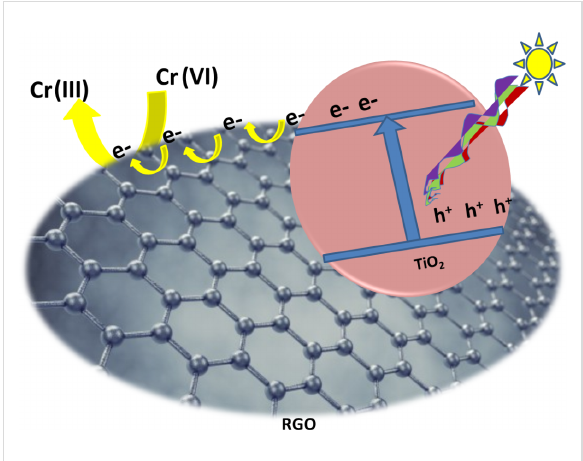
Figure 7: Transport of photoinduced electrons from the conduction band of TiO 2 through an RGO sheet, resulting in suppression of the recombination of charge carriers, which facilitates enhanced photocat- alytic reduction of Cr(VI).